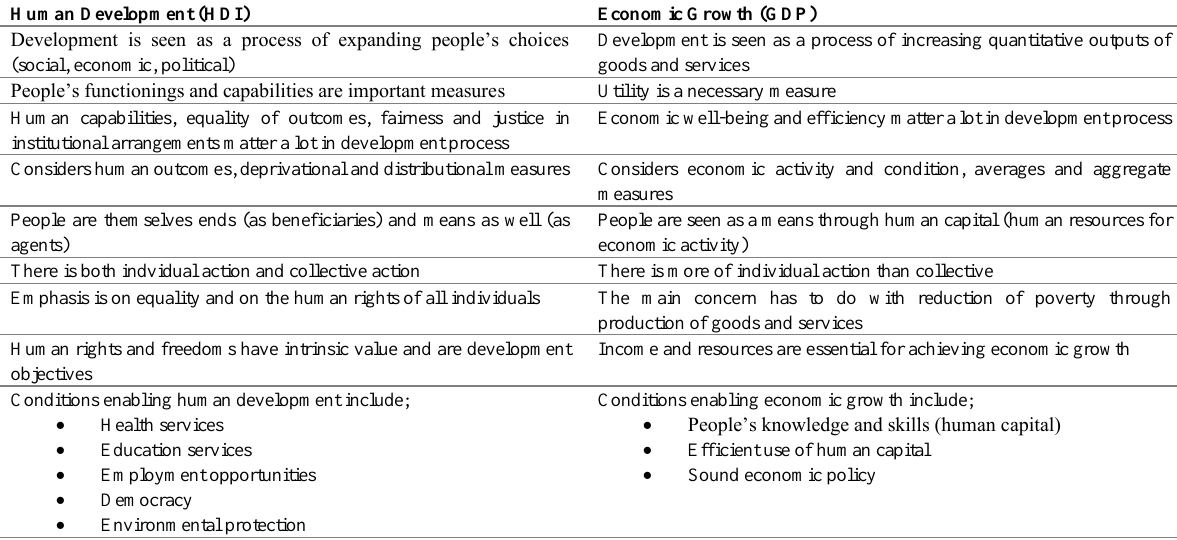
Table 1: Comparison between Human Development and Economic Growth Human Development